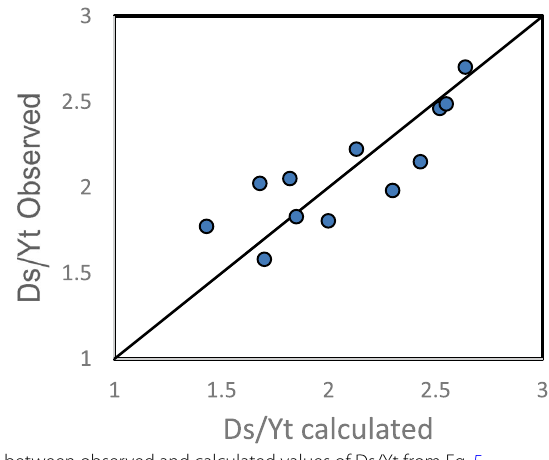
Fig. 8 Relationship between observed and calculated values of Ds/Yt from Eq.